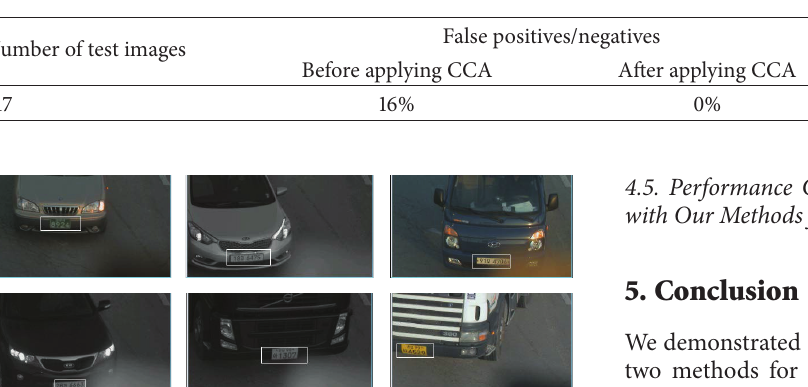
Table 2: LPD using adaptive thresholding.